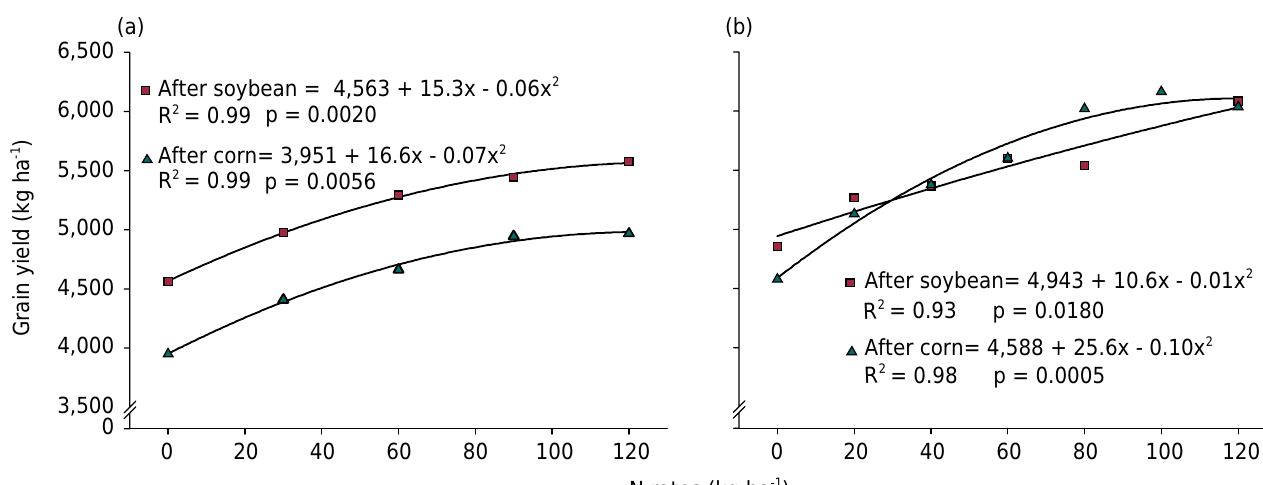
Figure 2. The relationship between grain yield of wheat (a) and barley (b) grown after soybean or corn and supplied with increasing urea-N rates in the South-Central region of Paraná. This relationship was established based on average results from experiments conducted between 2007 and 2012 (22 with wheat and 30 with barley).